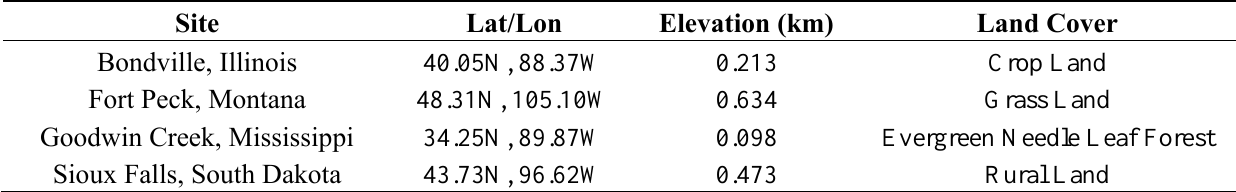
Table 1. Descriptions of the four SURFRAD